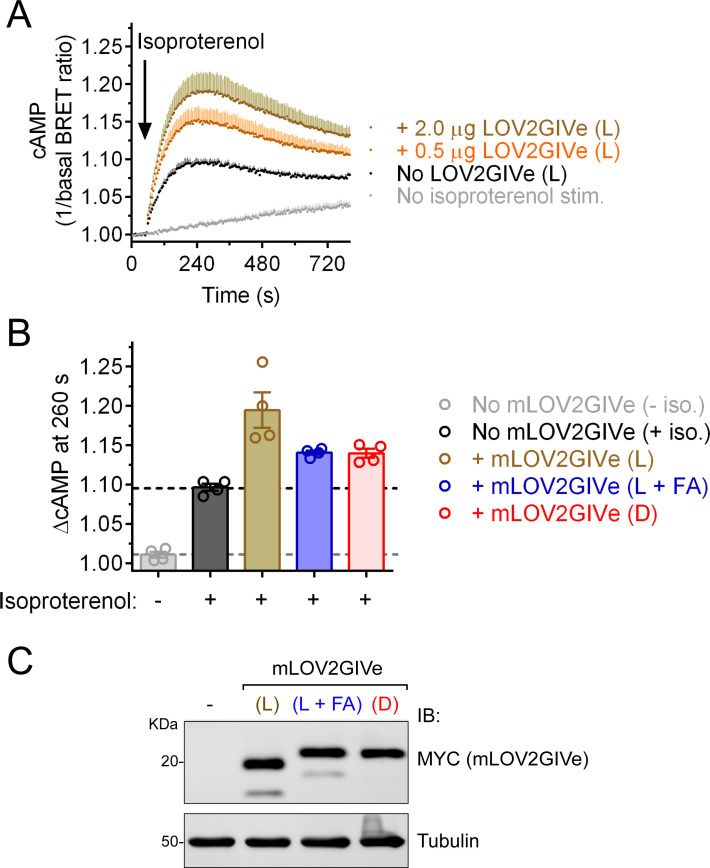
LOV2GIVe (L) expression enhances isoproterenol-induced cAMP levels in cells via Gi regulation.(A) Changes in cAMP levels upon isoproterenol stimulation (100 nM) were measured in HEK293T cells transfected with the NLuc-EPAC-VV BRET biosensor and the indicated amounts of plasmids encoding mLOV2GIV (L). Results are expressed as mean ± S.E.M of n = 4. Error bars (shaded in a color tone lighter than the corresponding data points) are displayed only in the positive direction for clarity. (B) The peak change of cAMP (200 s after isoproterenol injection time) was quantified in HEK293T cells transfected with 2 µg of plasmid DNA encoding the indicated mLOV2GIVe constructs. Results are expressed as mean ± S.E.M of n = 4. (C) Representative immunoblot from cell lysates made after the BRET measurements done for panel (B).
Figure 3—figure supplement 3—source data 1.Numerical data used for panel A.

Figure 3—figure supplement 3—source data 2.Numerical data used for panel B.